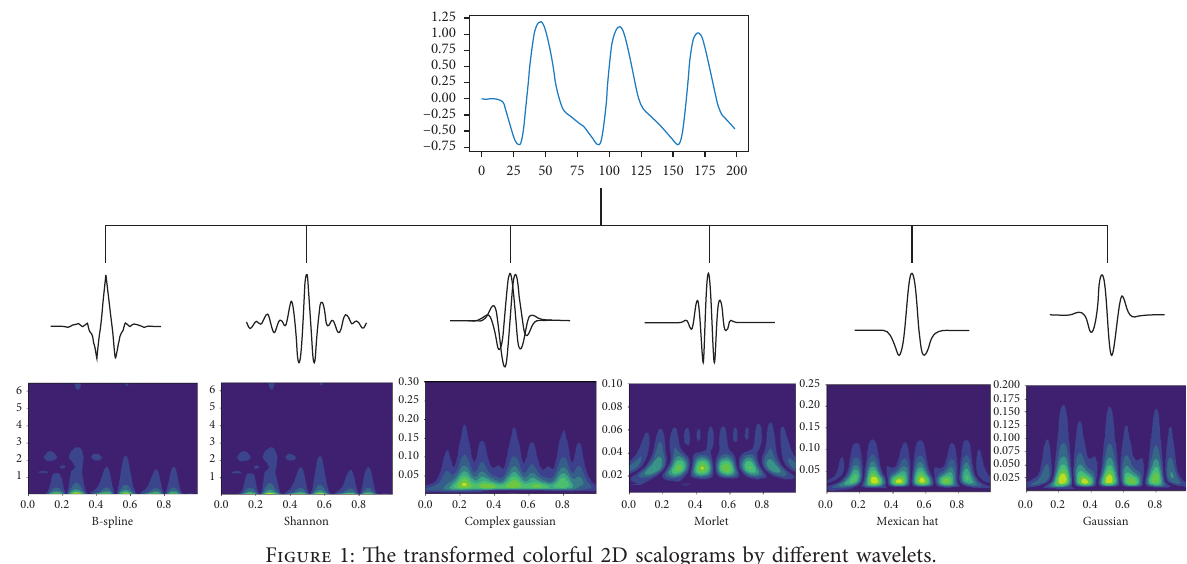
Figure 1: The transformed colorful 2D scalograms by different